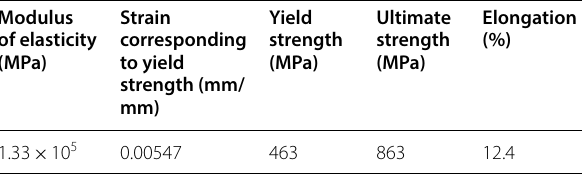
Table 2 Mechanical properties of Fe-SMA.